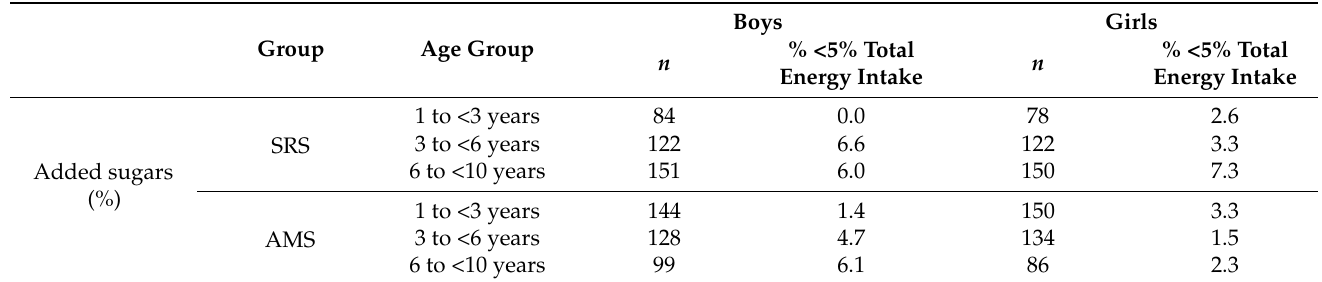
Table 4. Prevalence of adequacy (percentage of population below 5% total energy intake) in the Spanish Pediatric Population (EsNuPI) study.